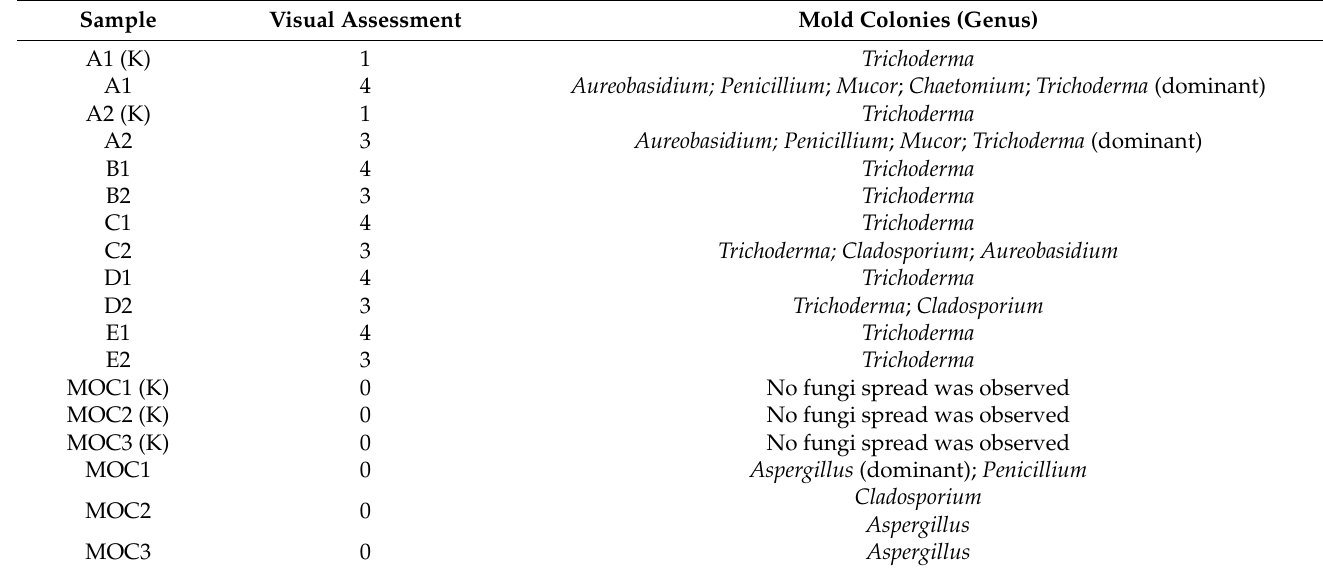
Table 6. Microscopically detected mold genera in samples.